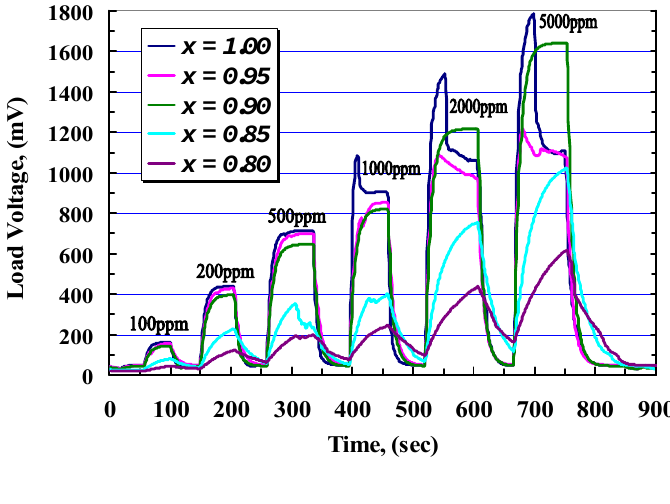
Figure 15. Response of samples to 0.01%, 0.02%, 0.05%, 0.1%, 0.2%, and 0.5% C measured at operating temperatures of 395 °C ( x = 1), 385 °C ( x = 0.95), 370 °C ( x = 0.9), 430 °C ( x = 0.85), and 440 °C ( x =